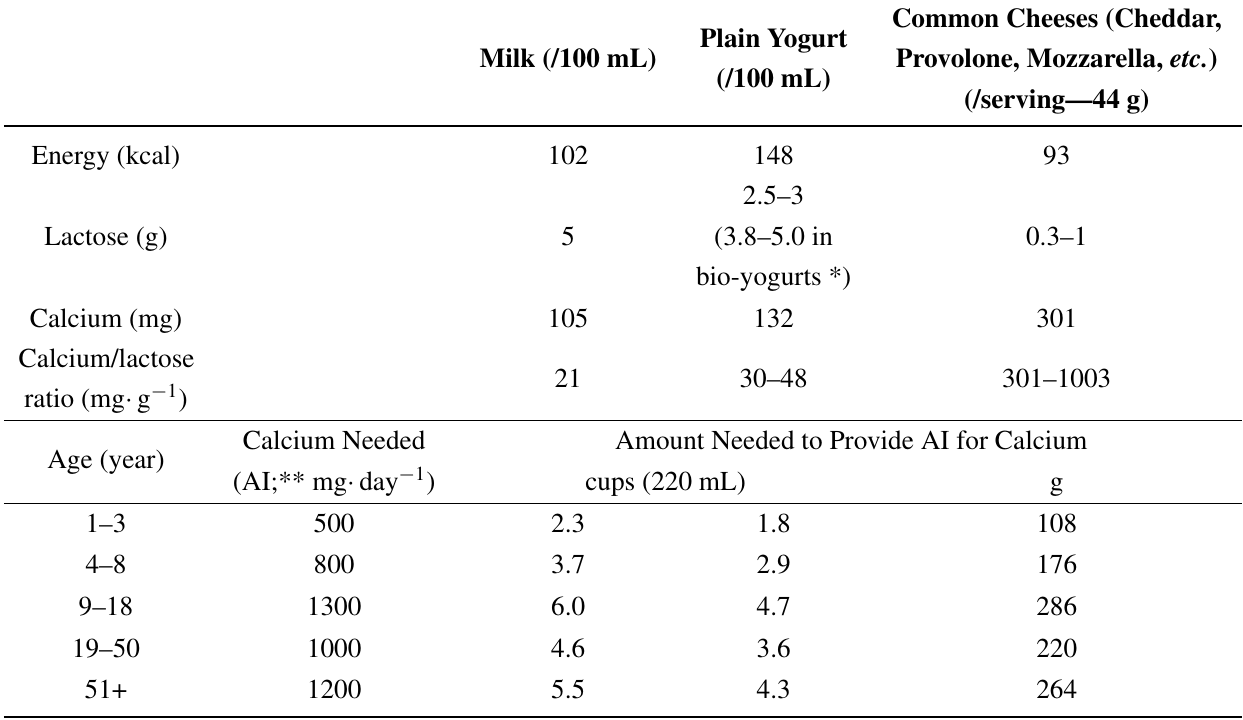
Table 7. Daily requirements of calcium by age and comparative serving equivalents of common dairy